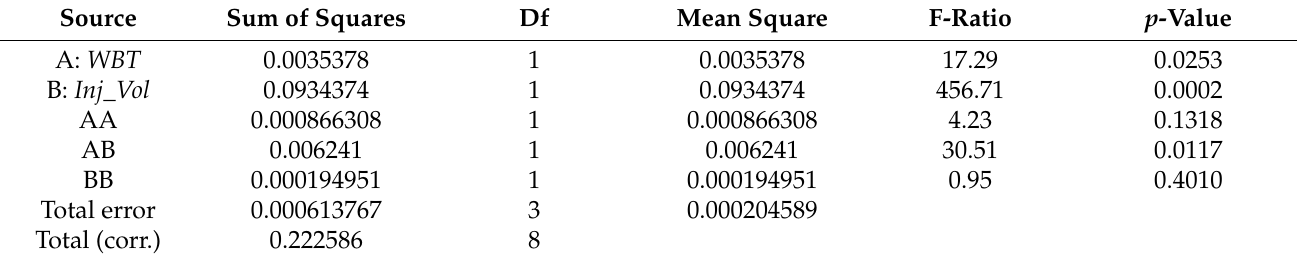
Table 6. Analysis of Variance for the restart pressure of the instantaneous pressure.